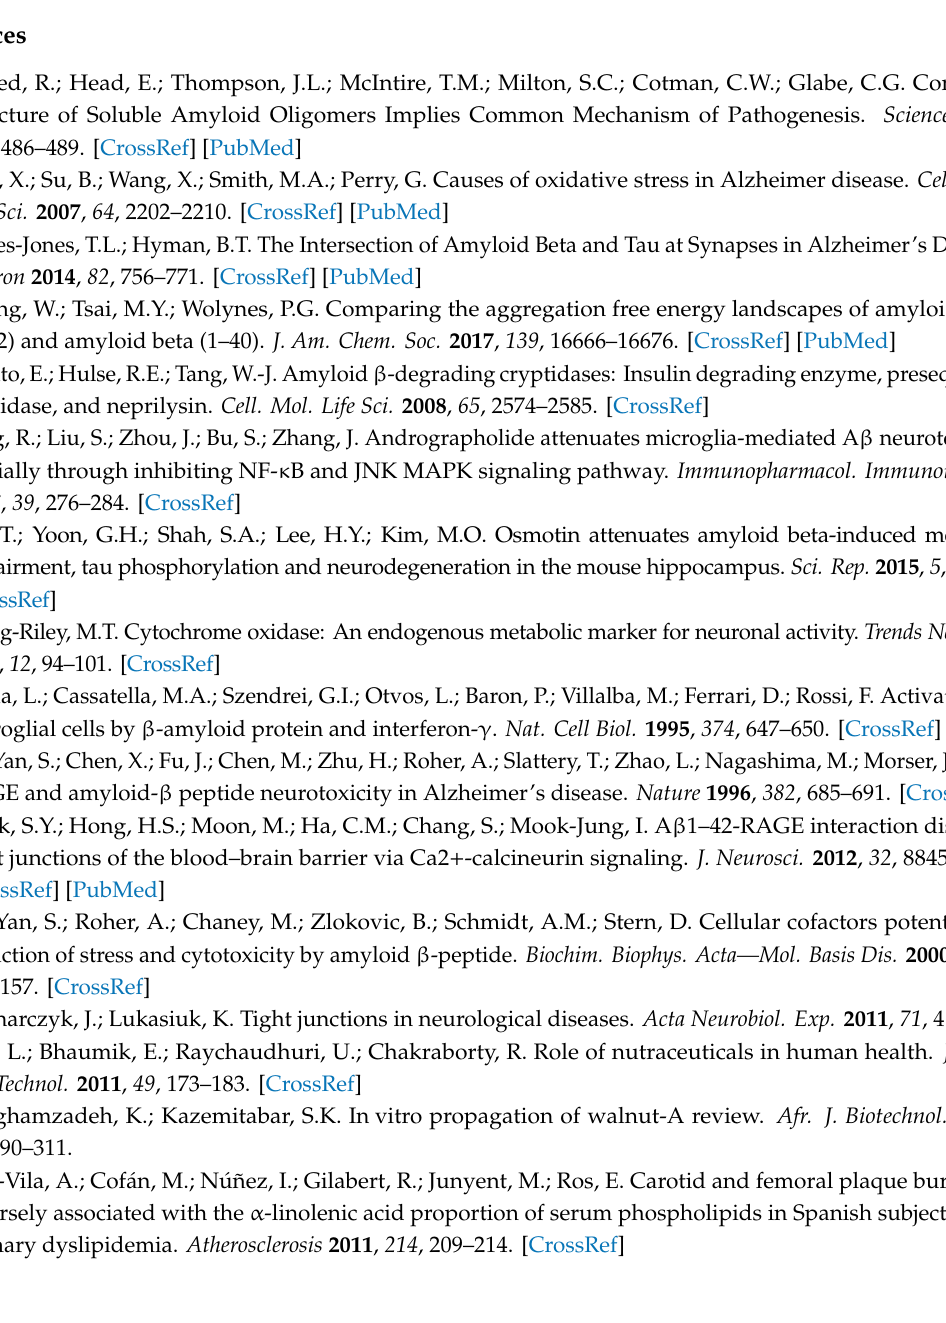
Figure S1: 2,2 (cid:48) -azino-bis(3-ethylbenzothiazoline-6-sulfonic acid) (ABTS) (A), 2,2-diphenyl-1-picrylhydrazyl (DPPH) (B) radical scavenging activity, and ferric reducing antioxidant power (FRAP) (C) of ethanolic extracts from Korean domestic cultivars (Gimcheon 1ho, Geumgok, and Geumreung) and imported from oversea cultivars (China and United States), Figure S2: Cell viability of walnuts ( Juglans regia L.; Geumgok cultivar) on H 2 O 2 -induced cytotoxicity in PC12 cells (A) and MC-IXC cells